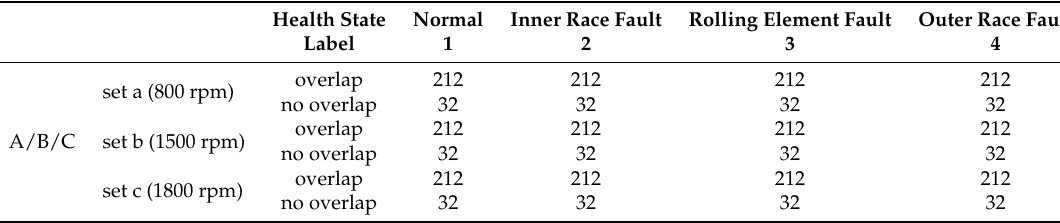
Table 1. Description of bearing